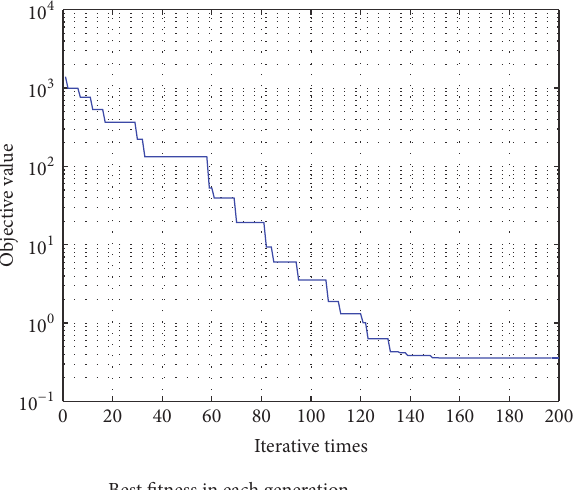
Figure 5: Fitness curve of global optimal points for GA.